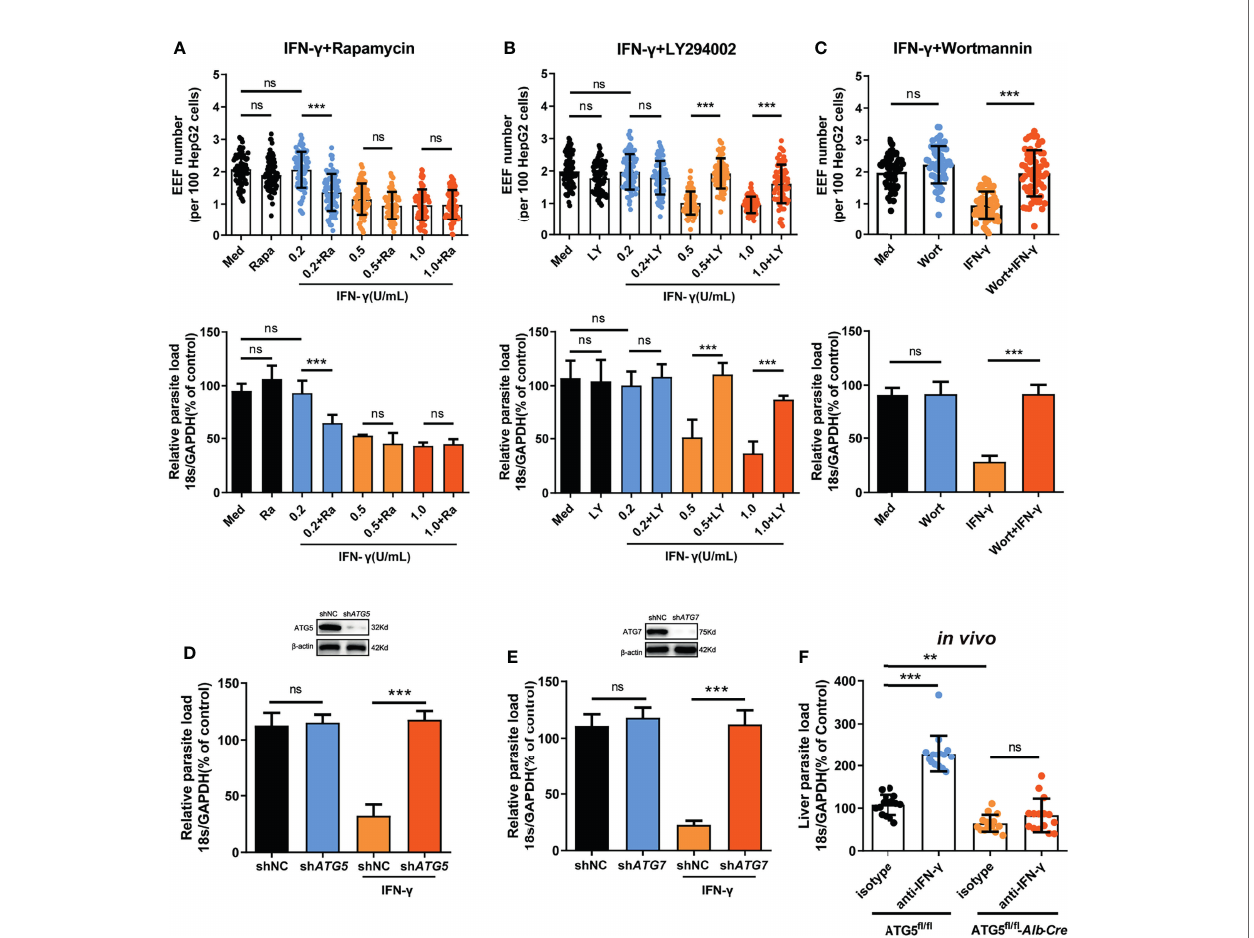
FIGURE 2 | Autophagy and ATGs are essential for the IFN- g -mediated killing of EEFs. (A) 1.2 × 10 5 HepG2 cells were pre-treated with or without the autophagy inducer rapamycin (Ra) and indicated concentrations of IFN- g and then incubated with 4 × 10 4 CSP wt sporozoites. The EEF number ( up , each dot represents one visual fi eld, n=75, magni fi cation, 630×) and the parasite load ( bottom ) at 46 h post-infection were determined and compared. Three individual experiments have been performed. Med, medium. (B) HepG2 cells were pre-treated with or without the autophagy inhibitor LY294002 (LY) and IFN- g at the indicated concentrations and then incubated with CSP wt sporozoites as above. The EEF number ( up , each dot represents one visual fi eld, n=75, magni fi cation, 630×) and the parasite load ( bottom ) at 46 h post-infection were determined and compared. The experiment has been repeated for three times. Med, medium. (C) HepG2 cells were pre-treated with or without the autophagy inhibitor wortmannin (Wort) at 100 mM and 1 U/mL IFN- g , and then incubated with CSP wt sporozoites as above for 46 h. The EEF number ( up , each dot represents one visual fi eld, n=60, magni fi cation, 630×) and the parasite burden ( bottom ) at 46 h post-infection were determined and compared. Three individual experiments have been performed. Med, medium. (D) HepG2 cells were transiently transfected with shNC or sh ATG5 plasmids, and then treated with 1 U/mL IFN- g and infected with CSP wt sporozoites as above for 46 h. The knockdown of ATG5 was veri fi ed by western blot ( up ), and the parasite burden ( down ) in HepG2 cells was determined and compared. Three individual experiments have been performed. (E) HepG2 cells were transiently transfected with shNC or sh ATG7 plasmids and then treated with 1 U/mL IFN- g and infected with CSP wt sporozoites as above for 46 h. The knockdown of ATG7 was veri fi ed by western blotting ( up ), and the parasite burden ( down ) in HepG2 cells was determined and compared. The experiment has been performed for three time. (F) After IFN- g was depleted with or without anti-IFN- g , both control (ATG5 fl / fl ) and ATG5 fl / fl - Alb - Cre mice were intravenously injected with 1,000 CSP wt sporozoites, 46h later, the liver parasite burdens were measured and compared. Each dot represents one mouse (n=15). The pooled data of three repeated experiments was presented, data are represented as mean ± SD and analyzed by One-Way ANOVA. ns, not signi fi cant; **P < 0.01; ***P <